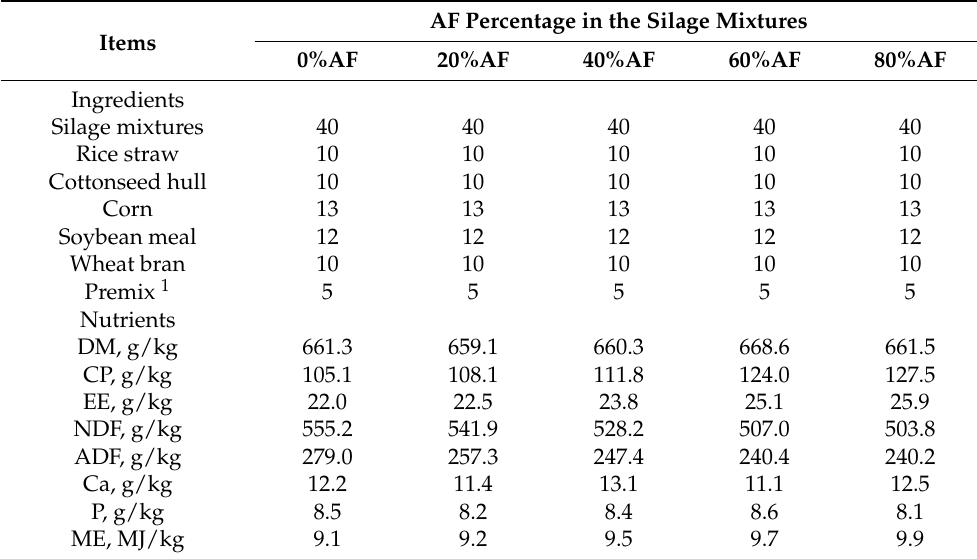
Table 1. Ingredients and chemical compositions of alfalfa–sweet sorghum (AF–SS) silage-based diets.